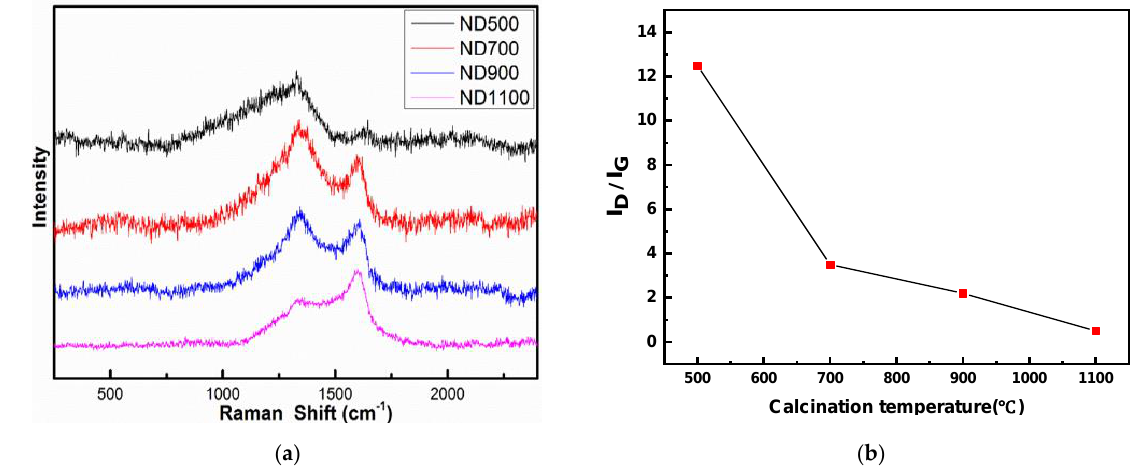
Figure 2. ( a ) Raman spectra of ND500, ND700, ND900, and ND1100 catalysts. ( b ) The I D /I G data in the ND catalysts with different calcination temperatures. Table 1. The I D /I G data of the samples based on Raman. Catalyst